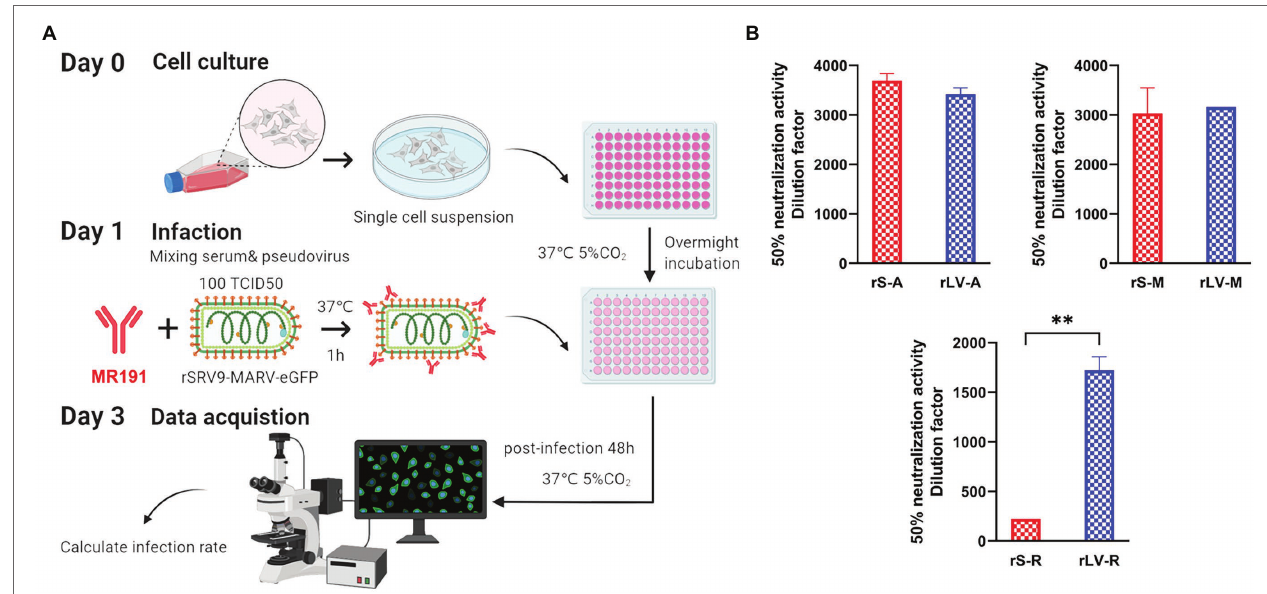
FIGURE 2 | Pseudovirus neutralization assay based on SRV9 reverse genetic operating system (A) Neutralization assay operation process. The pseudovirus of 10 2 TCID 50 was incubated with the test sample (such as serum) with or without nAb at 37 ° C for 1 h. The incubated mixture was inoculated into BSR cells and continued to incubate for 48 h, followed by fluorescence microscopy to assess the samples’ neutralizing activity. If nAb is present in the sample or the antibody has neutralizing activity, the pseudovirus is neutralized, and no green fluorescence in the form of flaky aggregates can be observed after 48 h incubation of the mixture. Conversely, a large amount of green fluorescence can be observed. (B) Comparison results with lentivirus-type pseudovirus systems. Data represent the mean ± Standard error of the mean (SEM) of 3 replicate tests per sample. For normalization of the results, the infectious dose that protects 50% of the cells from fluorescence is calculated by the Reed–Muench method. The calculated dilution factor is used as the neutralization potency. Differences between the two groups of data were analyzed by t